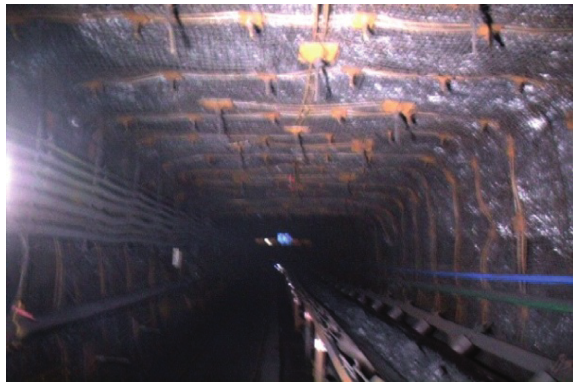
Figure 20: The stability of the 8108